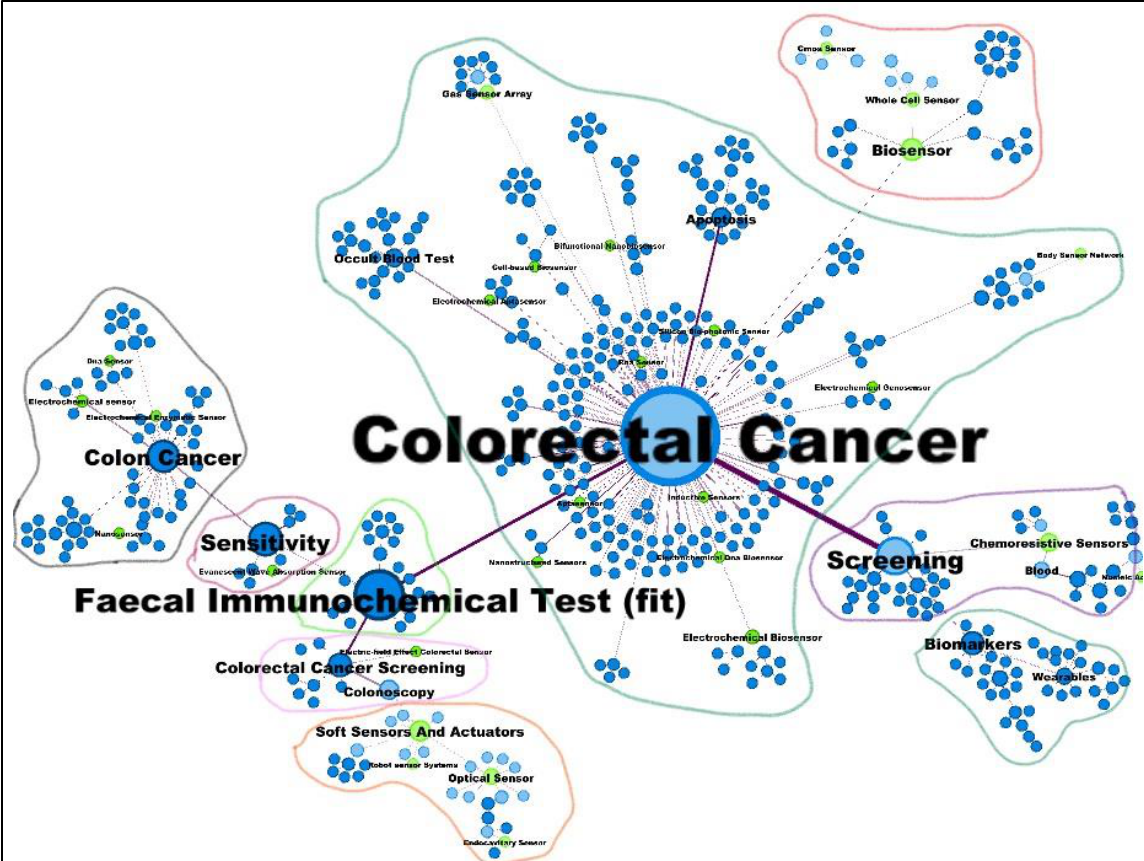
Figure 5. Co-word analysis map of colorectal